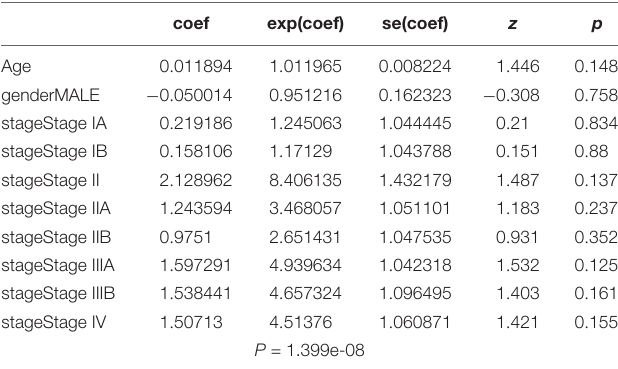
TABLE 4 | Univariate and multivariate regression analysis of age, gender, and tumor stage.